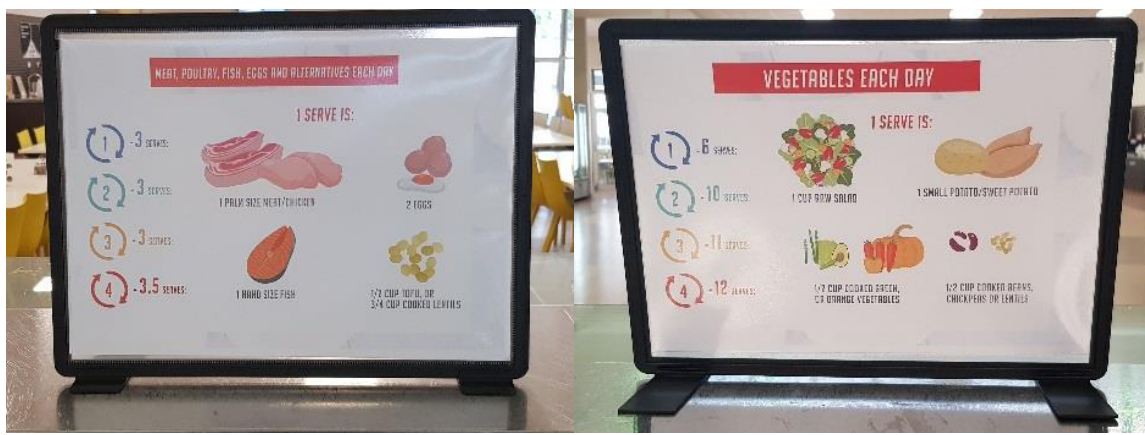
Figure 3. Food labels (positioned on food counters).